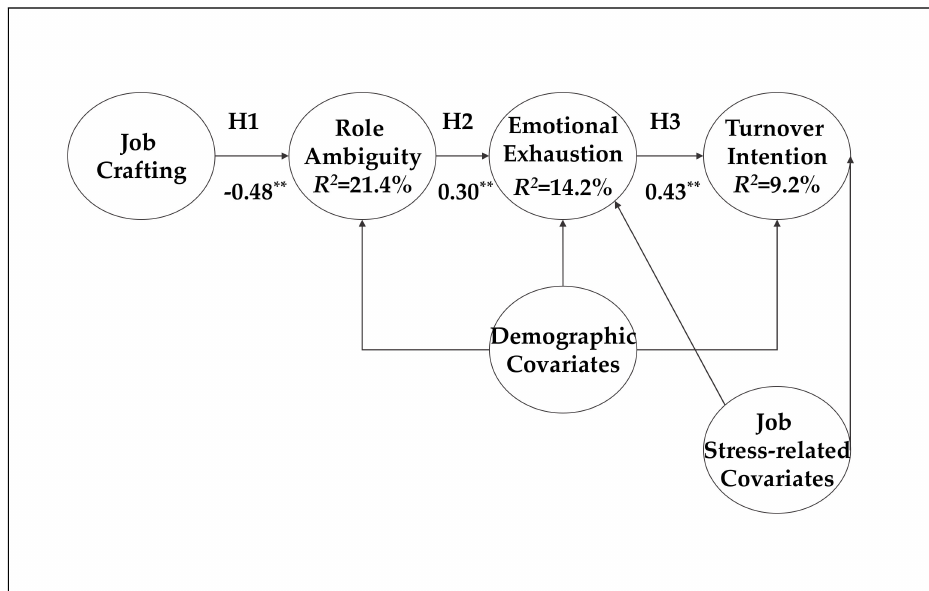
Figure 2. Proposed research model and summary of results. Unstandardized coe ffi cients are reported. For parsimony, path coe ffi cients for demographic and role stress covariates are omitted. * p < 0.05, ** p <